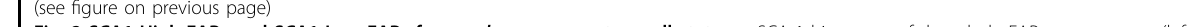
Fig. 2 SCA1-High-FAPs and SCA1-Low-FAPs from mdx mouse are two cell states. a SCA-1 histogram of the whole FAP compartment (left), freshly isolated cell states (middle) and cell states expanded 9 days in Cytogrow (right). FAP compartment was analysed as followed: CD45 − CD31 − cells isolated by MACS were stained with antibodies against Integrin alpha-7 and SCA-1; next a gating strategy (Supplementary Fig. 4b; unstained cells in Supplementary Fig. 4a) was applied to obtain Integrin alpha-7 − SCA-1 + cells. Cell states were isolated as described and then analysed by fl ow cytometry (gating strategy in Supplementary Fig. 4d, e for SCA1-High-FAPs and SCA1-Low-FAPs respectively; controls in Supplementary Fig. 4c) ( n = 3). b Schematic representation of the in vivo experiment. Freshly isolated FAP cell states were stained and injected into TAs of mdx mice. After 3 days SCA-1 expression of stained cells was studied by fl ow cytometry. c Upper panel: dot plots showing stained FAP cell states three days after the injection. Lower panel: SCA-1 distributions of FAP cell states in three different condition: freshly isolated, after 3 days in vitro and after 3 days in vivo ( n = 3). d Representative crop of micrographs of SCA1-High-FAPs (left) and SCA1-Low-FAPs (right) cultured ex vivo. Cytoplasms were stained with CFSE (yellow) and nuclei were counterstained with Hoechst 33342 (blue). Scale bar 50 μ m. e – g Box plots representing CFSE positive area, aspect ratio (AR) and roundness of SCA1-High-FAPs (n = 96) and SCA1-Low-FAPs (n = 94) from three different biological replicates. Whiskers are minimum and maximum values of the distribution. Statistical signi fi cance was estimated by a two tailed Mann – Whitney test after a normality